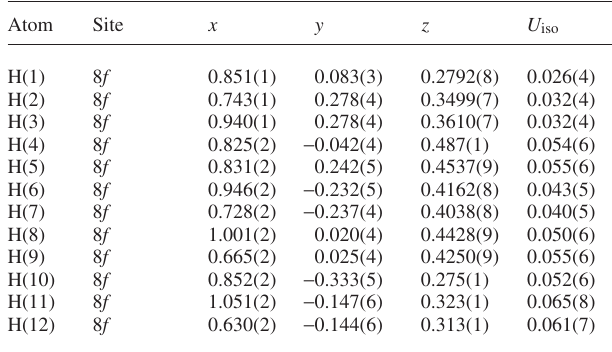
Table 2. Atomic coordinates and displacement parameters (in Å 2 )